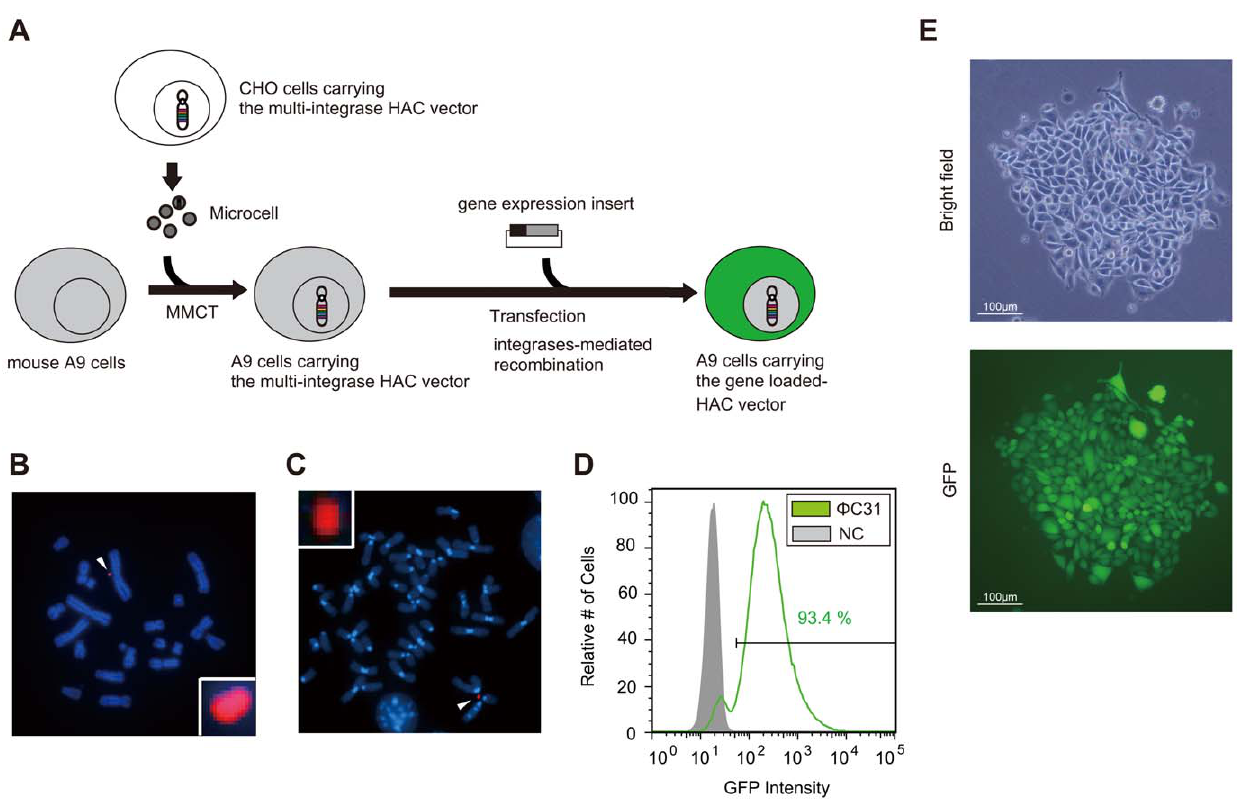
Figure 4. The multi-integrase HAC vector is transferable to other cell lines. (A) Microcell-mediated chromosome transfer (MMCT) of the multi-integrase HAC vector into mouse A9 cells and subsequent introduction of gene expression cassettes. (B) Typical FISH image of CHO cells carrying the multi-integrase HAC vector. The arrowhead indicates the multi-integrase HAC vector. (C) Shown is a representative metaphase spread hybridized to the human COT-1 probe (red) in A9 hybrids. (D) By flow cytometry analysis, the proportion of GFP-positive transfected A9 cells was determined. The gray curve indicates cells without a GFP expression cassette, the green curve indicates cells obtained by the multi-integrase HAC vector with W C31 integrase. The bar indicates the GFP-expressing cell population. (E) GFP expression was detected in the G418-resistant A9 cells by fluorescence microscopy. Representative images (bright field, upper panels; fluorescence, lower panels) of cells obtained with the multi-integrase HAC vector with W C31 integrase are shown. Scale bar, 100 m